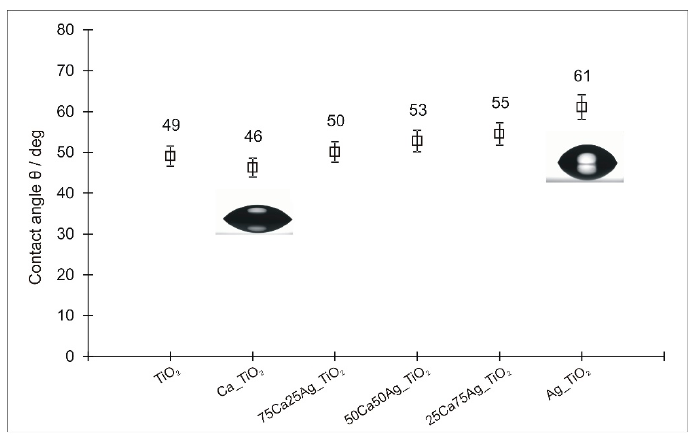
Figure 7. Contact angles Θ of the titania-based coatings on M30NW alloy samples depending on doped ions.